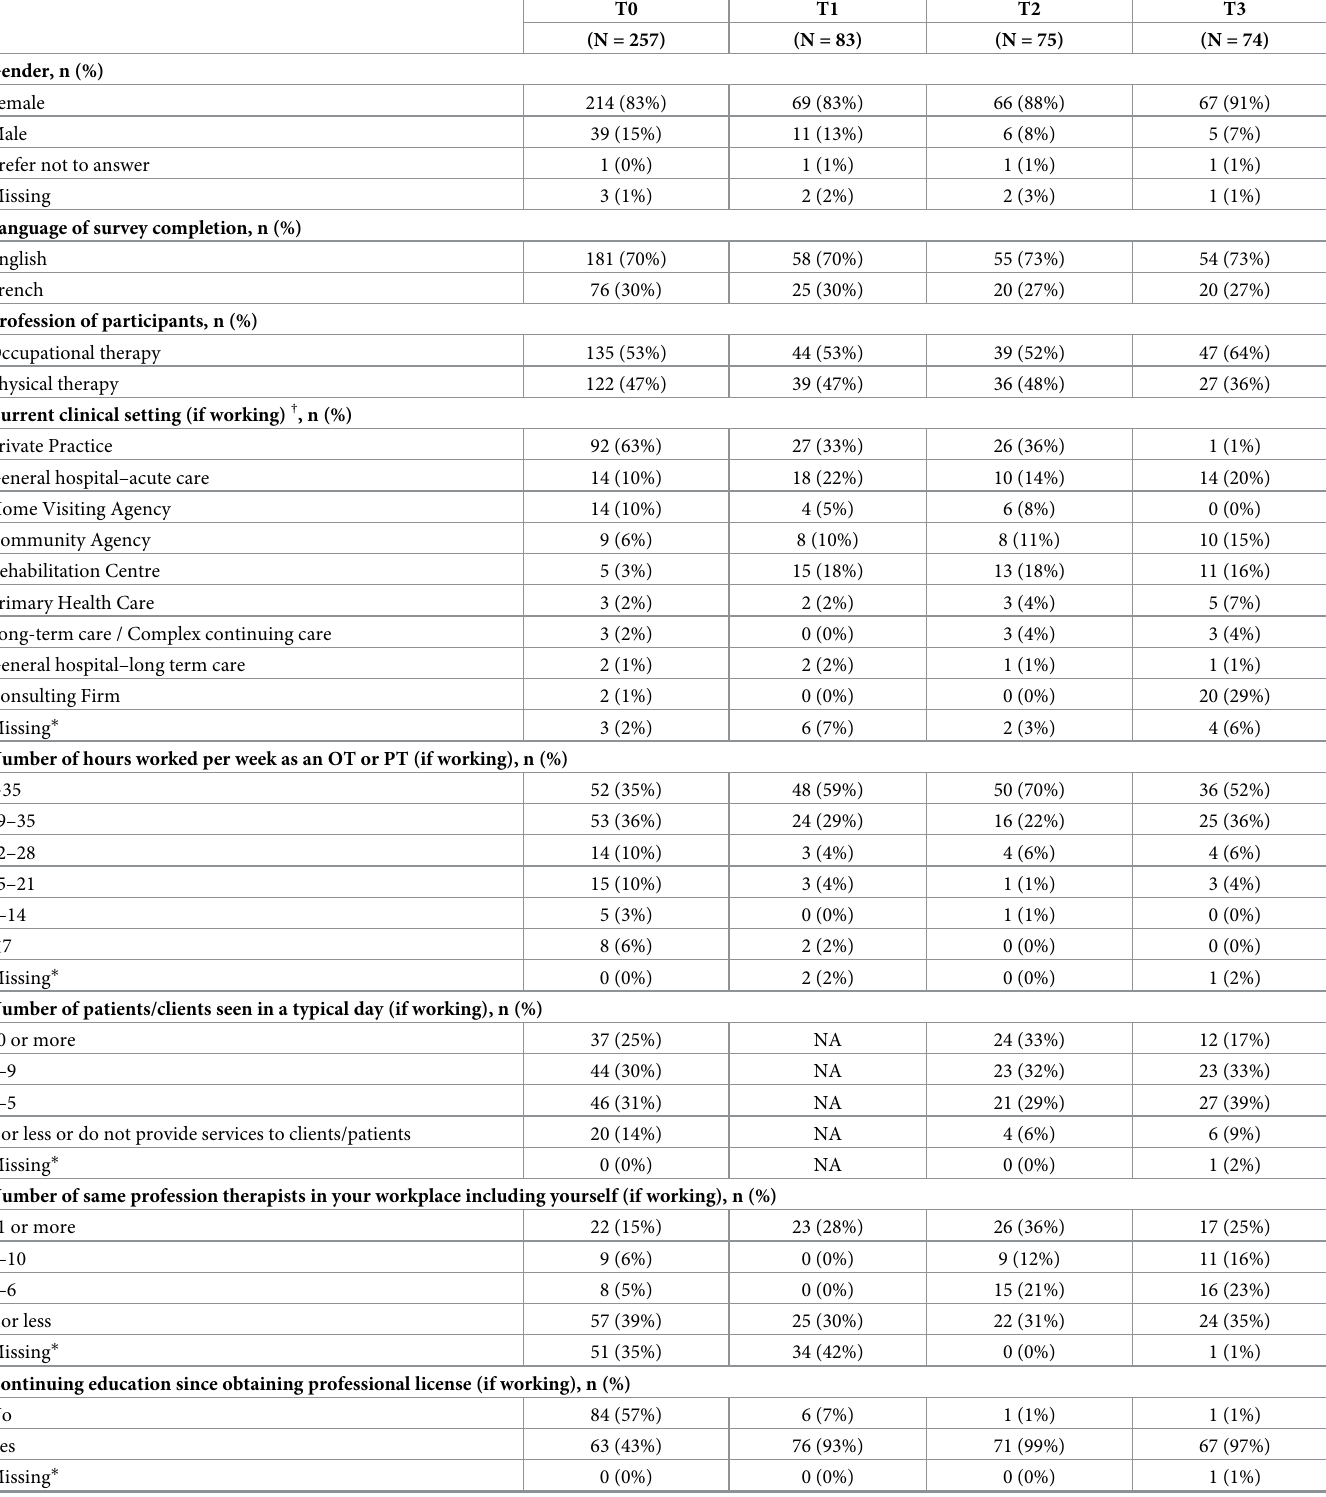
Table 1. Time points wise characteristics of the participants including raw scores on the six EBP constructs